Question: Write a single sentence explaining what this figure depicts.
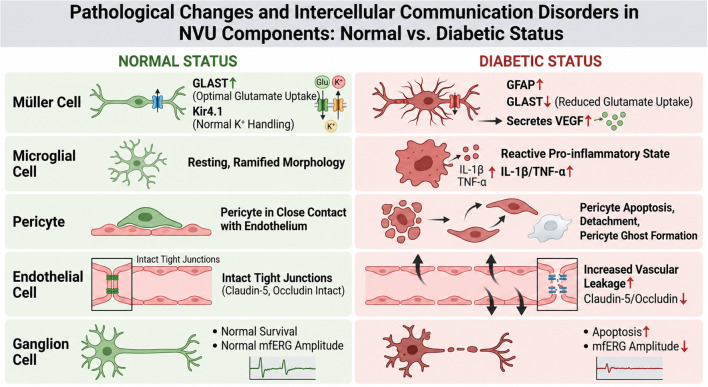
Answer: Pathological changes and intercellular communication disorders in neurovascular unit (NVU) components under diabetic stress. Chronic hyperglycemia induces distinct but interconnected changes in neuronal, glial, and vascular components of the NVU, including neuronal dysfunction and apoptosis, glial activation and neuroinflammation, endothelial injury, pericyte loss, and blood-retinal barrier breakdown. These changes collectively contribute to neurovascular uncoupling and diabetic retinopathy (DR) progression.